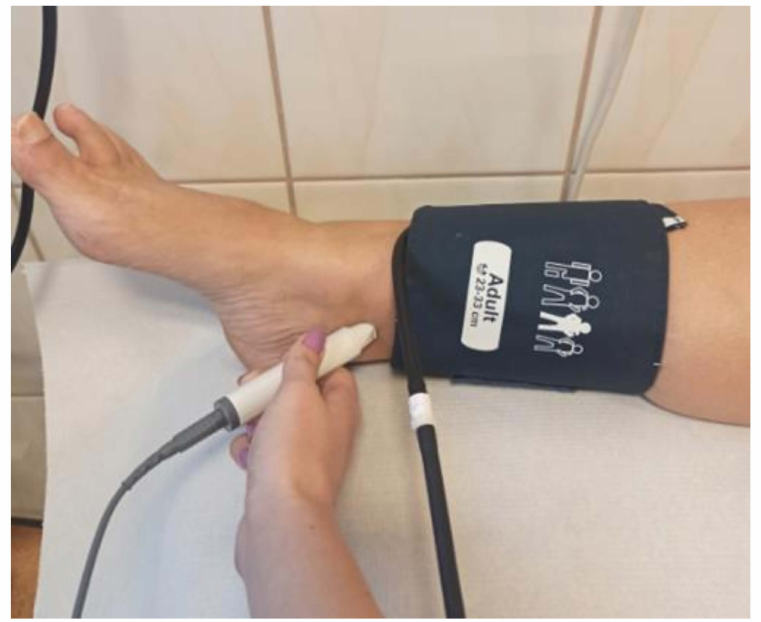
Figure 1. Doppler ABI